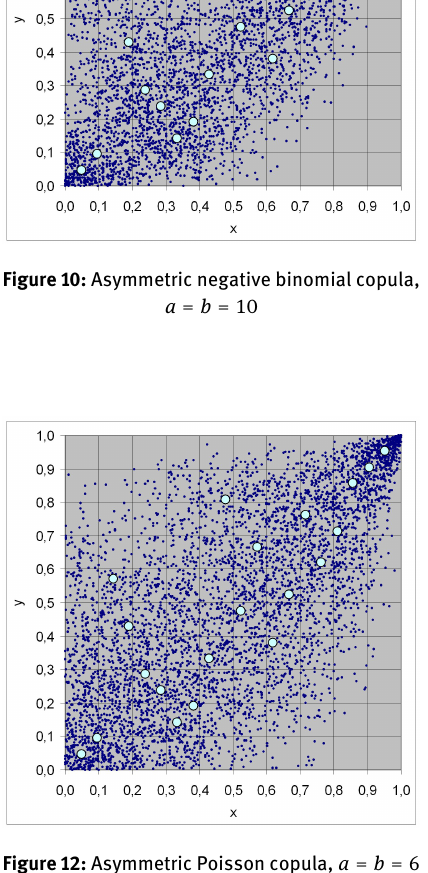
Figure 11: Symmetric Poisson copula, a = b = 6 Figure 12: Asymmetric Poisson copula, a = b =